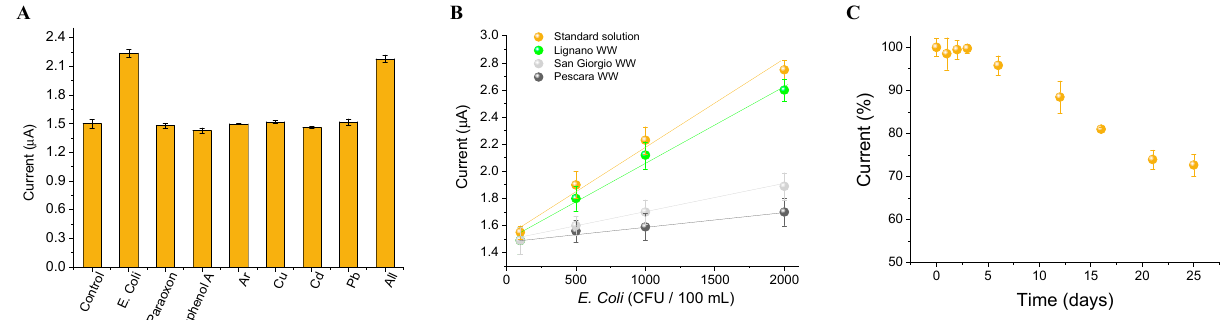
Figure 7. ( A ) Interference analysis using 10 ppb arsenic, 1.3 ppb copper, 5 ppb cadmium, 10 ppb lead, 10 ppb bisphenol A, and 1 ppb paraoxon, and a solution spiked with all the compounds. ( B ) Matrix effect using Lignano, San Giorgio, and Pescara wastewater samples. ( C ) Storage stability expressed as light-induced oxygen evolution.